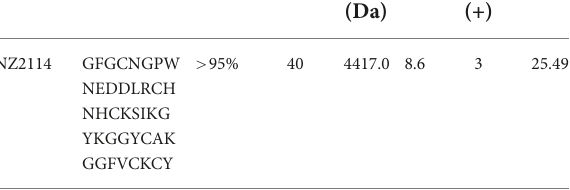
Peptide Sequence Purity Length MW